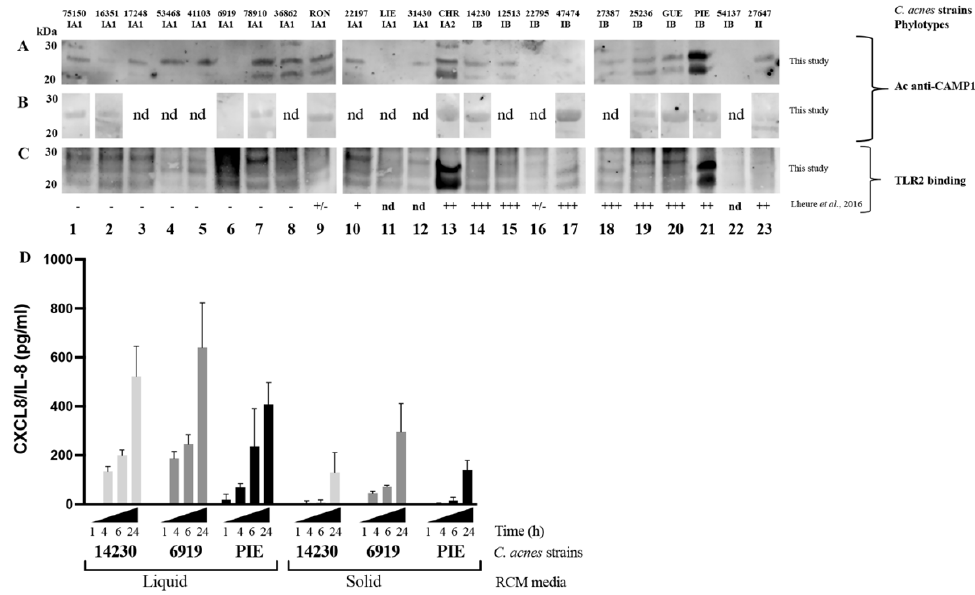
Figure 1. Expression of Christie–Atkins–Munch–Petersen (CAMP)1 in Cutibacterium acnes ( C. acnes ) strains. C. acnes surface proteins were extracted from a five-day culture ( A , C ) in liquid RCM medium or ( B ) on solid RCM medium and separated by electrophoresis in a 4–12% NuPAGE SDS BisTris gel (50 µ g). Separated proteins were transferred onto nitrocellulose membranes, which were incubated ( A , B ) with antibodies against CAMP1 or ( C ) with recombinant toll like receptor (TLR)-2. TLR-2 binding activity was detected with specific biotinylated antibodies against TLR-2, as described in the Materials and Methods. TLR-2 binding activity previously reported by Lheure et al. [24]. Lanes 1 to 12 correspond to phylotype IA1 strains: 75150, 16351, 17248, 53468, 41103, 6919, 78910, 36862, RON, 22197, LIE and 31430, respectively. Lane 13 corresponds to phylotype IA2 strain: CHR. Lanes 14 to 22 correspond to phylotype IB strains: 14230, 12513, 22795, 47474, 27387, 25236, GUE, PIE and 54137, respectively. Lane 23 corresponds to phylotype II strain: 27647. ( D ) HaCaT cells were stimulated for 1, 4, 6 and 24 h at 37 °C, with C. acnes strains 6919 (phylotype IA1), 14230 (phylotype IB) or PIE (phylotype IB) grown in liquid or on solid medium. C-X-C motif chemokine ligand interleukin (CXCL)8/(IL)-8 protein levels were assessed by enzyme-like immunosorbent assay (ELISA). nd: non-determined.